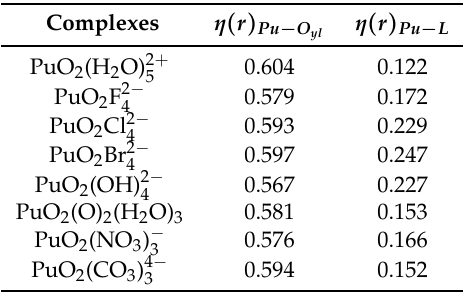
Table 6. ELF η ( r ) values corresponding to (3, − 1) BCPs associated with Plutonium center and O yl and Ligand in Plutonyl (VI) complexes